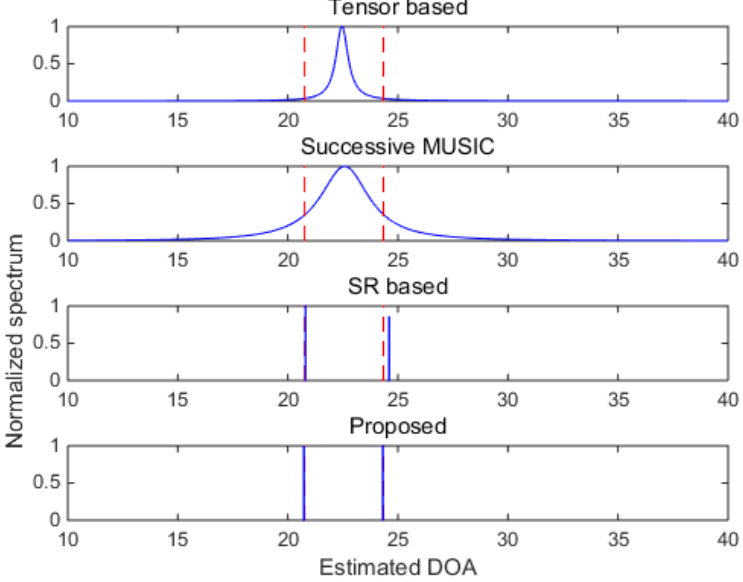
Figure 7. DOA estimation results with closely spaced sources (SNR = 5 dB).